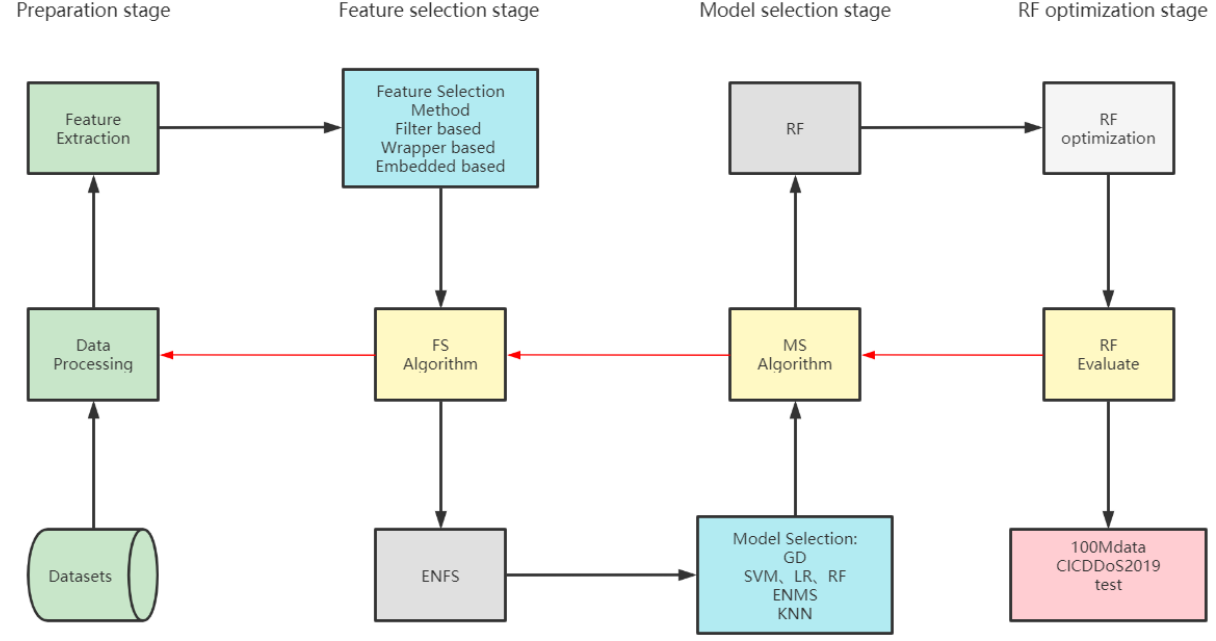
Figure 1. Framework for feature selection and model selection methods (FAMS).